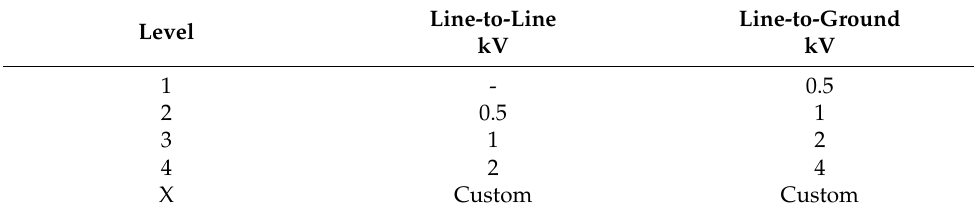
Table 1. Open circuit test voltage levels